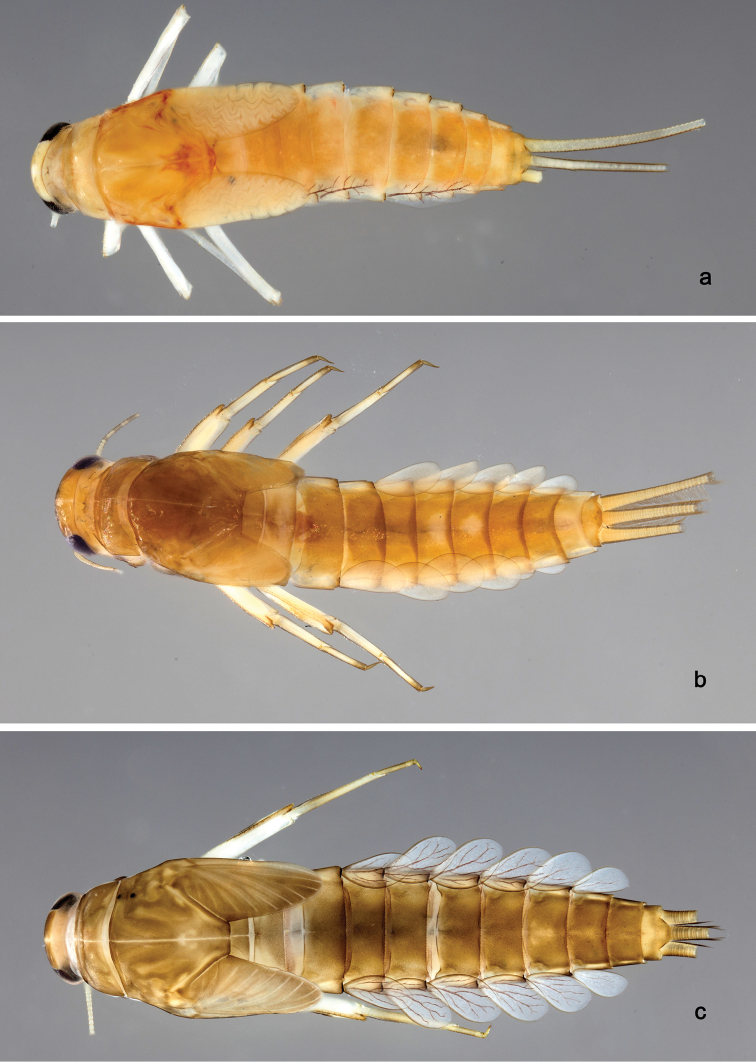
Habitus, larvae: aLabiobaetisparavitilis sp. n., dorsal view bLabiobaetiswilhelmensis sp. n., dorsal view cLabiobaetisparavultuosus sp. n., dorsal view.